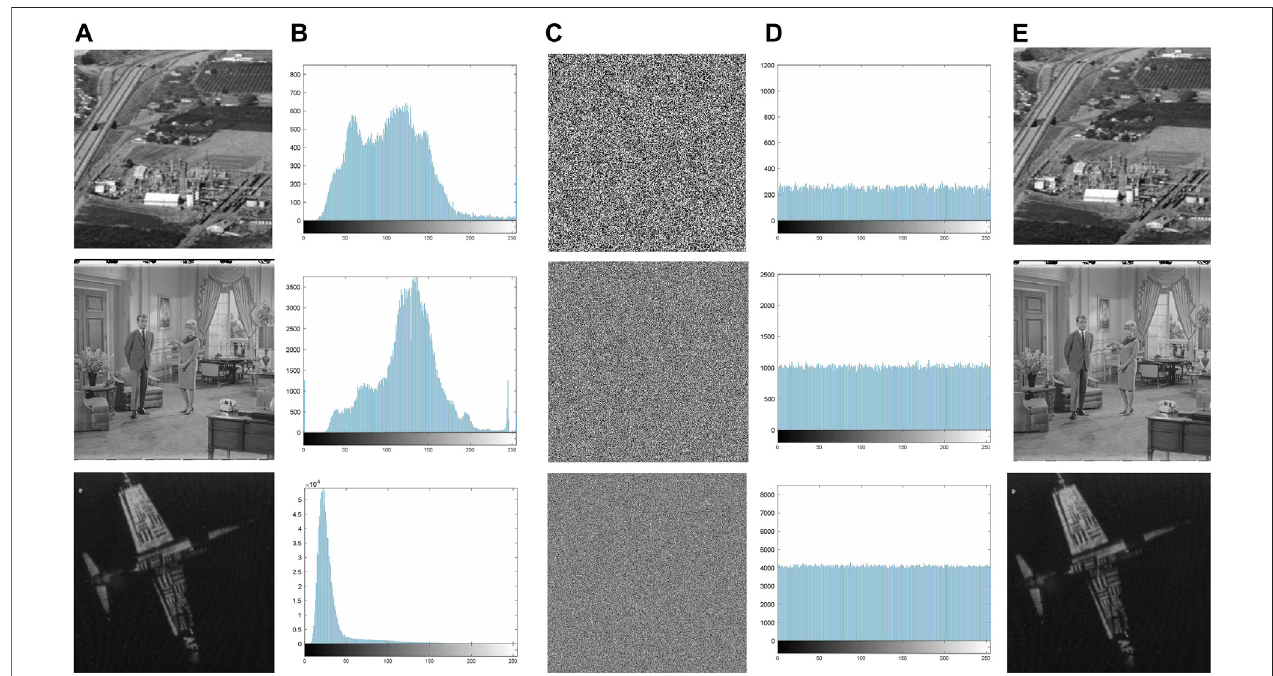
FIGURE 3 | Gray image [43] simulation results: (A) plain images, (B) histograms for (A) , (C) encrypted images, (D) histograms for (B) , and (E) decrypted images.